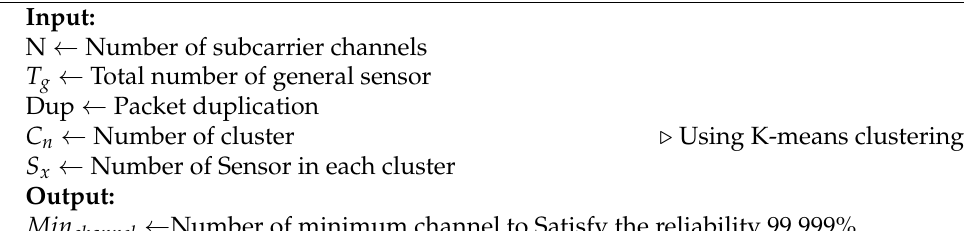
Algorithm 1 Minimum subcarrier channel detection algorithm